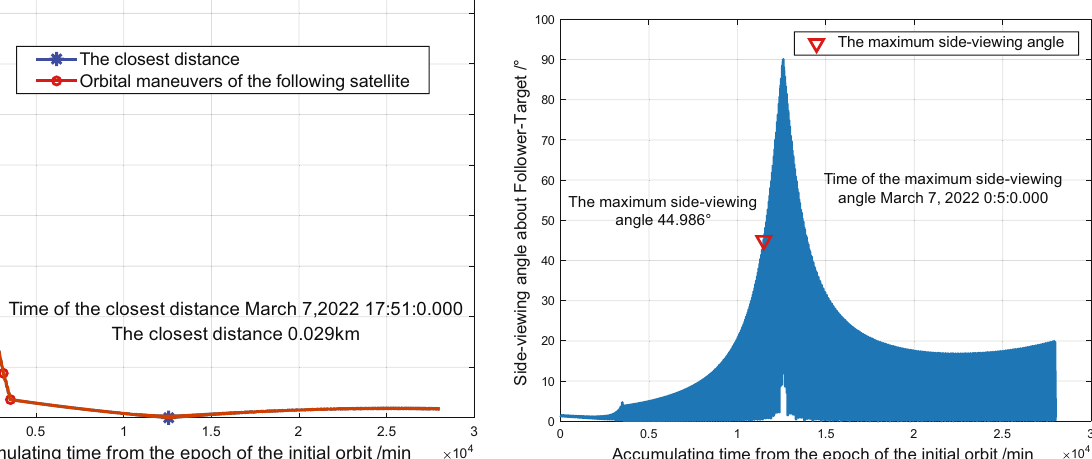
Figure 3: Variation in the line - of - sight angle of two satellites caused by the capture control